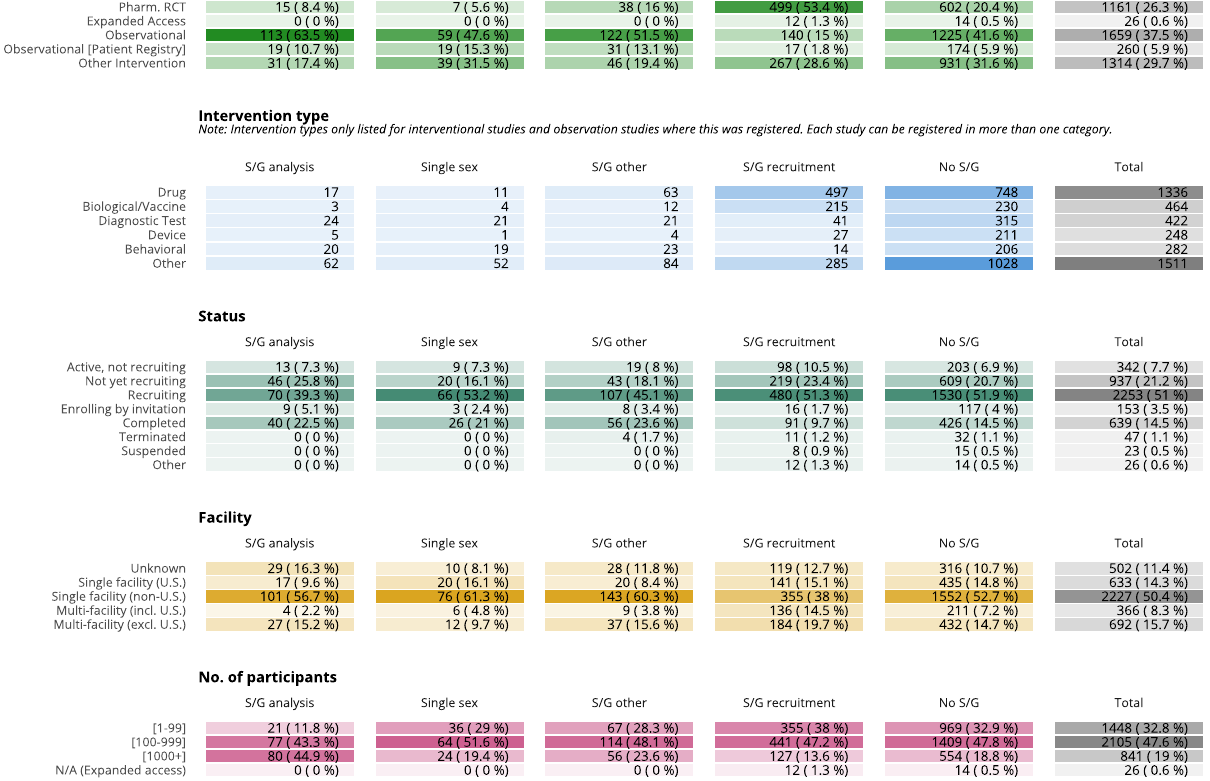
Fig. 2 Properties of COVID-19 Studies in the sample and level of attention to sex/gender (S/G). Sex/gender coding and properties of studies at time of data collection on 26 January 2021. Studies are reported according to different analytical criteria. Color blocks represent one category of analysis. Studies are exclusively allocated to one category per analysis, with the exception of the “ intervention ” category. Here, studies can propose multiple interventions and, hence, appear under each unique intervention type they include. In the facility section, we focus on the number (single or multiple) and location (US or non-US) of the facilities recruiting participants into the studies. Address information for facilities is available for 89% of our full COVID-19 set. All studies (except the 26 Expanded Access) provide enrollment details and they are mostly ‘ anticipated ’ , i.e. target numbers